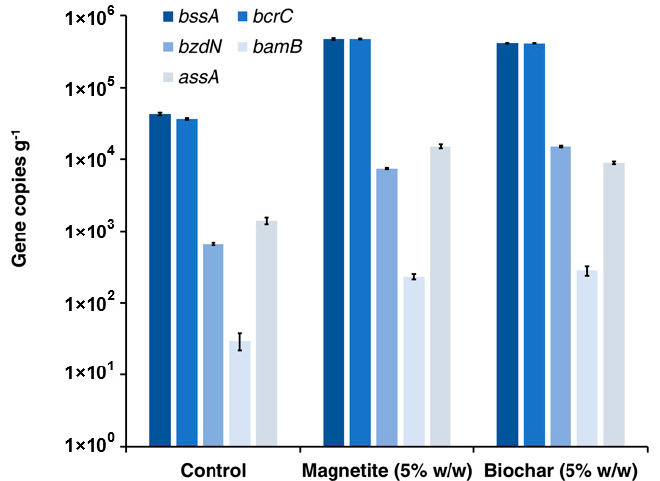
Figure 8. The abundance of key-functional genes involved in anaerobic toluene and alkanes degradation was estimated by qPCR in soil samples taken at the end of experiments. bssA , benzylsuccinate synthase; bcrC and bzdN , benzoyl CoA reductases class I; bamB , benzoyl CoA reductase class II; assA , alkylsuccinate/2-(1-methylalkyl) succinate synthase. Data are reported in the Log scale.